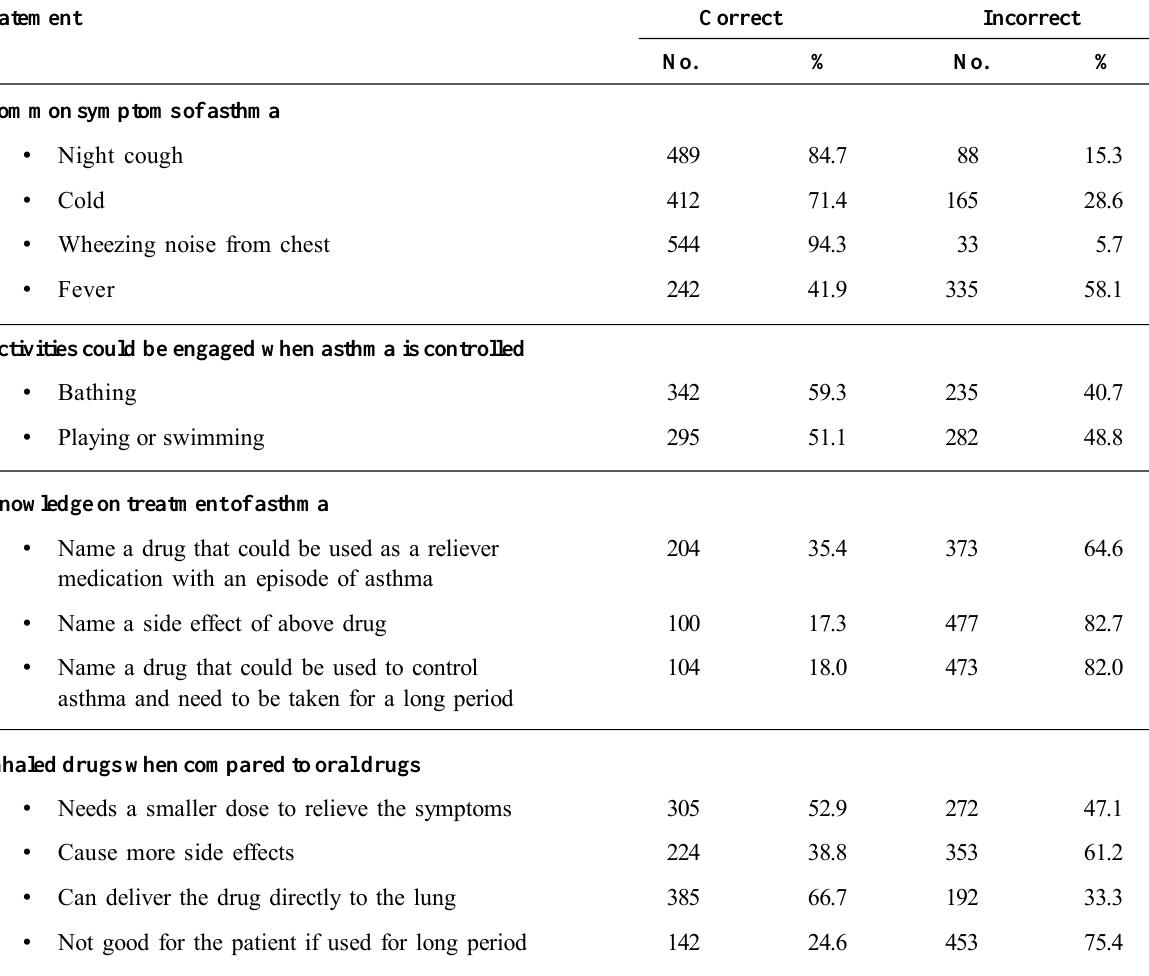
Table 2. Distribution of the caregivers’ knowledge on primary and